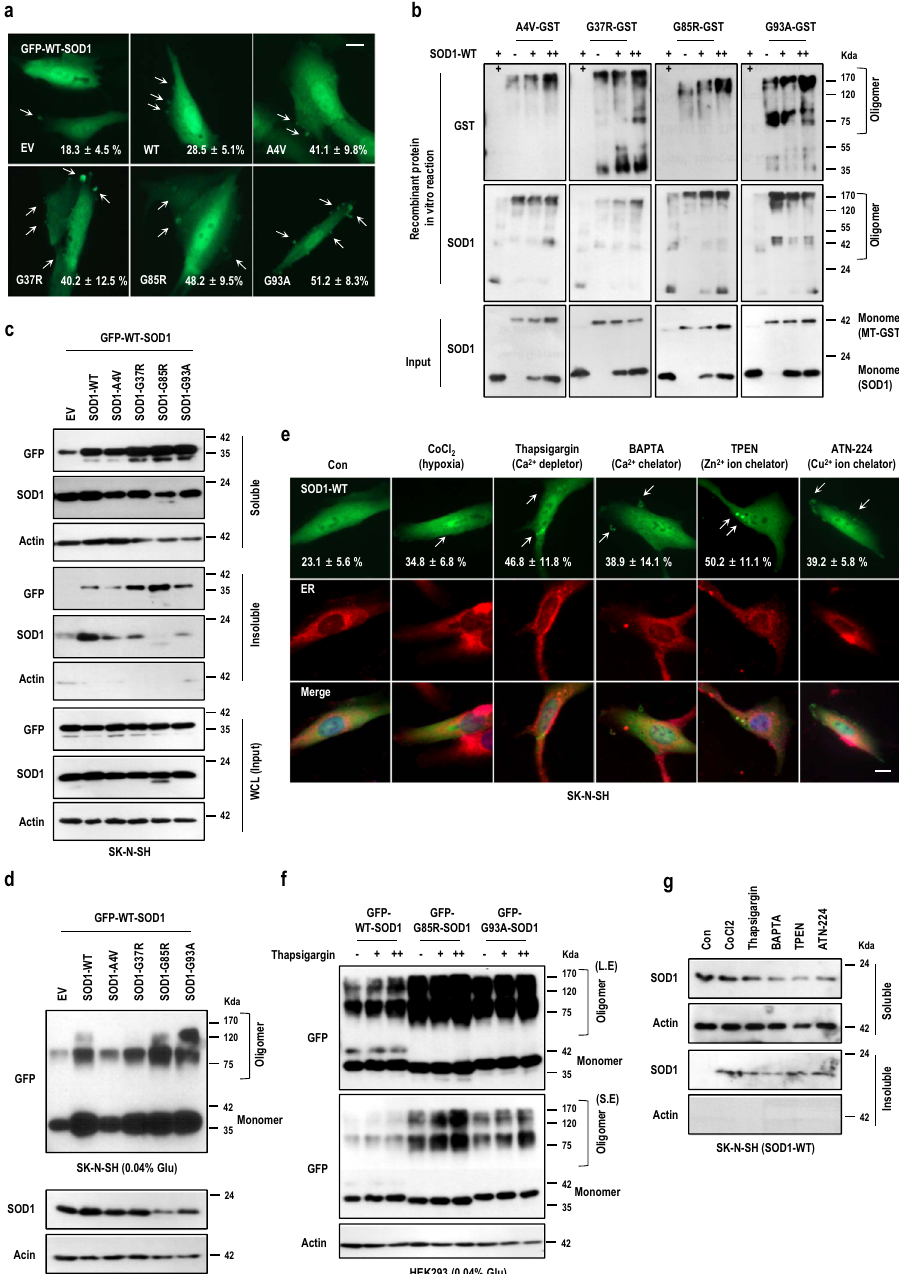
(white arrow) of MT-SOD1, but not with other candidates (Fig. 2c, d and S2f-i). To check whether Chem-036 can reduce the insoluble and oligomer formation of WT-SOD1 by MT-SOD1 overexpression, GFP-WT-SOD1 was co-transfected into HEK293 cells expressing each MT-SOD1s. As shown in Fig. S2j and k, Chem-036 could reduce the oligomer and insoluble formation of WT-SOD1 by SOD1 overexpression, respectively. Furthermore, we con fi rmed that Chem-036 also inhibited the oligomer for- mation of WT-SOD1 by TPEN (Fig. 2e) and it reduced insoluble formation of WT and MT-SOD1 upon cellular stress by thapsi- gargin (Fig. S2l and m). Including thapsigargin (endoplasmic reticulum Ca 2 + depletor) and BAPTA (Ca 2 + chelator), TPEN (Zn 2 + chelator), CoCl 2 (hypoxia-inducer), and ATN-224 (Cu 2 + chelator) induced the inclusions in cells were signi fi